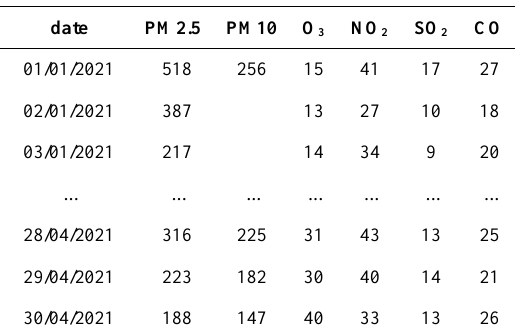
Table 1. Anand Vihar, India air quality